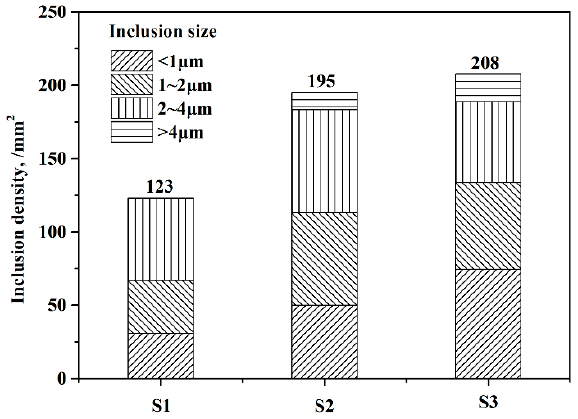
Figure 12. Inclusion size and density of each sample.